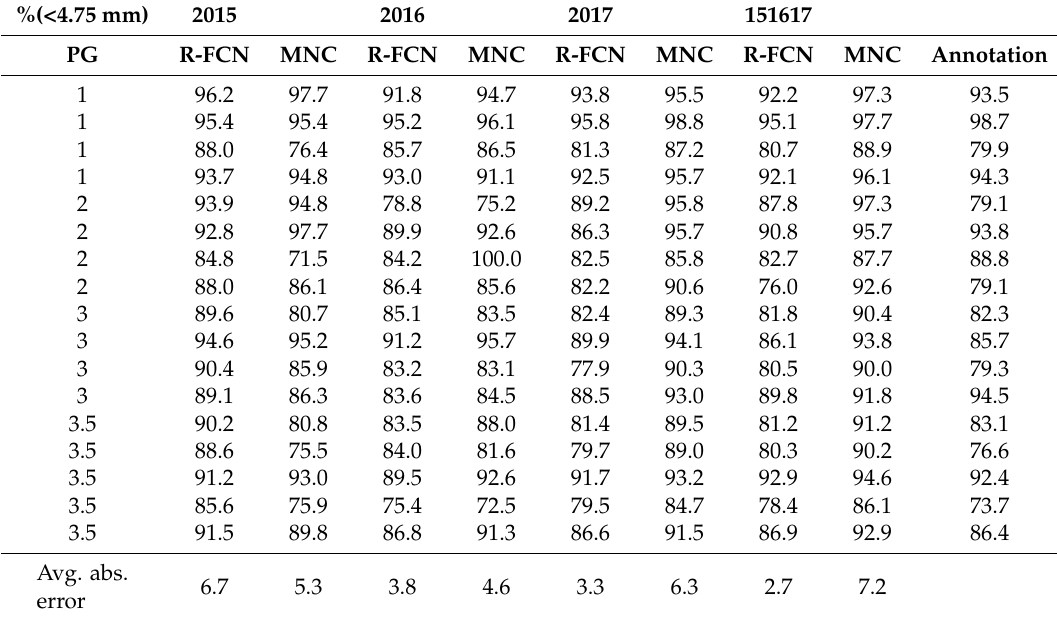
Table 4. Kernel Processing Score (KPS) results across sequences of varying PGs for R-FCN and MNC models. The final row shows the average absolute error for each model over all sequences from the 2017 test